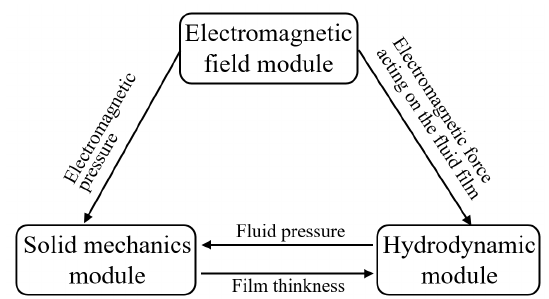
Figure 5. Schematic diagram of the coupled calculation of Electromagnetic-Elastic Mechanics-Hydrodynamics Multiphysics Coupling Model for metal liquid film.